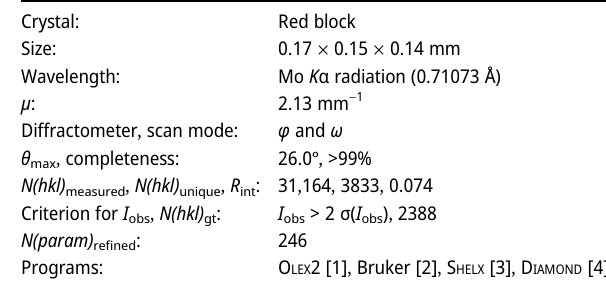
Table  : Data collection and